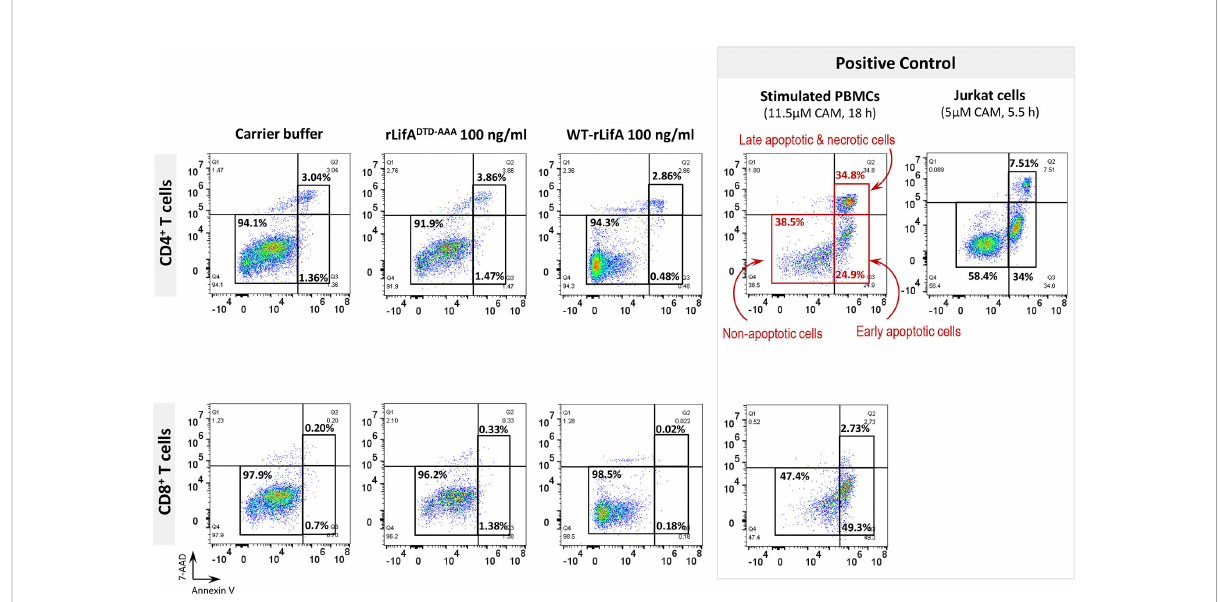
FIGURE 8 Flow cytometric dot plots represent the percentage of non-apoptotic, early apoptotic, and mixture of late apoptotic and necrotic CD4 + and CD8 + T cells treated with WT-rLifA, rLifA DTD-AAA , or carrier buffer. Data are representative of one sample. The anti-CD3/anti-CD28-stimulated CD4 + and CD8 + T cells treated with 11.5 µM camptothecin for 18 h and Jurkat T cell line treated with 5 µM camptothecin for 5.5 h were used as positive controls of apoptosis and necrosis. CAM;